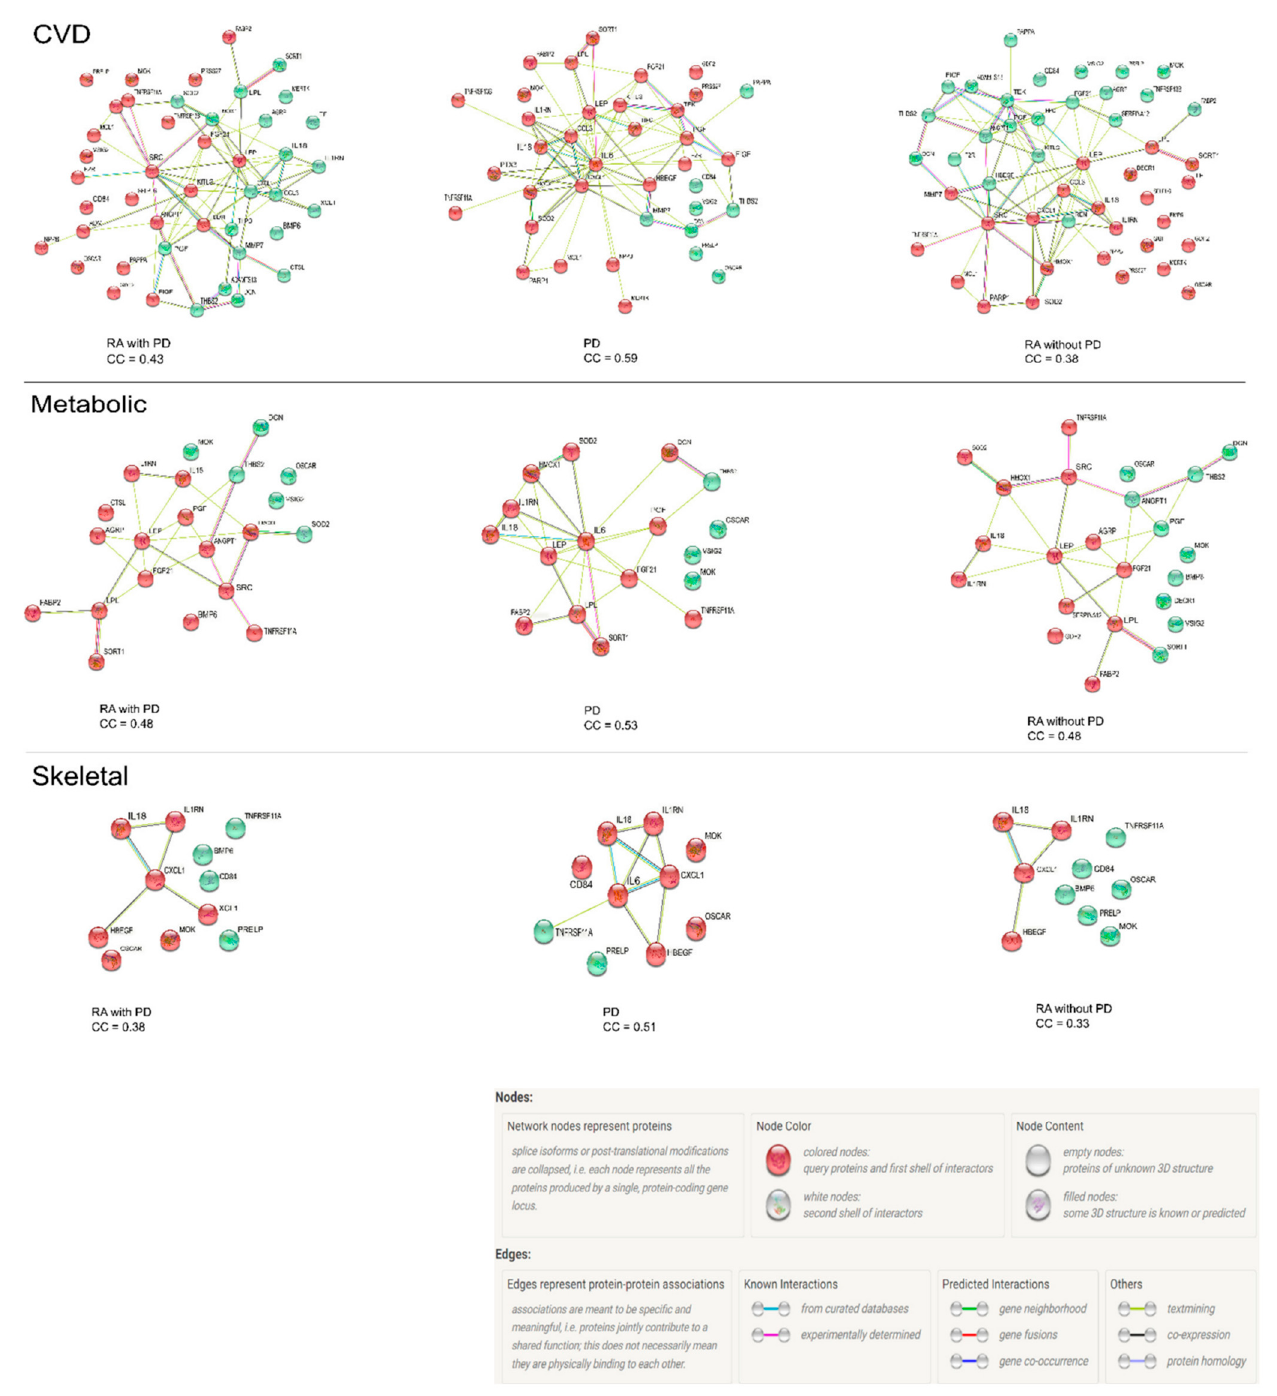
Figure 4. PC1 biomarkers and their protein network analysis according to disease area in RA with PD, PD, and RA without PD groups. The network nodes represent proteins with red colored nodes denoting first shell interactors and green color showing second shell of interactors. All cluster coefficients (CC) have a PPI enrichment value of <0.0001.